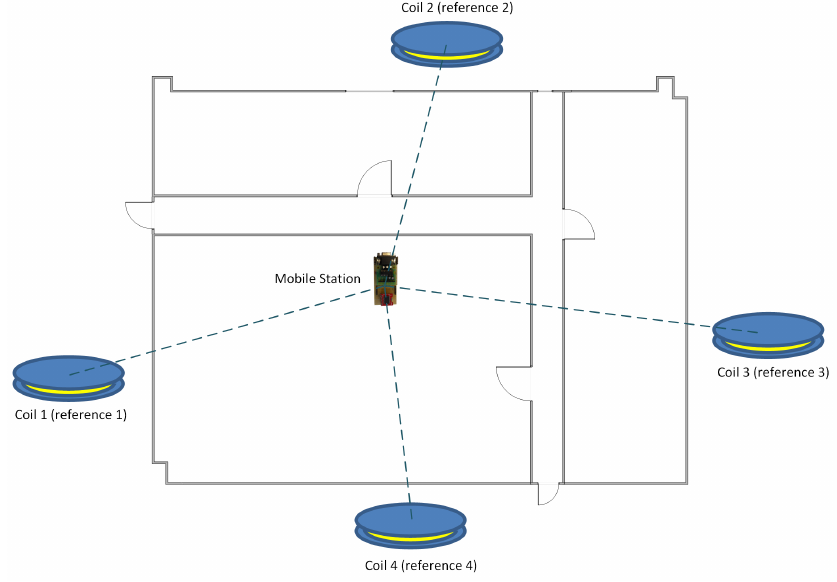
Figure 8. Magnetic indoor local positioning system (MILPS) principle.